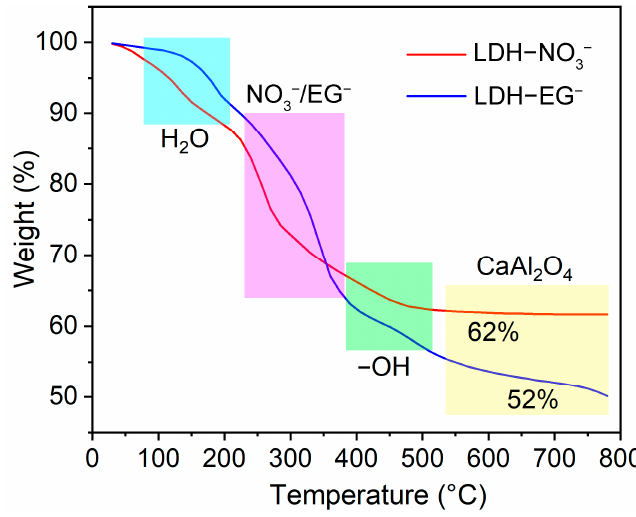
− and CaAl LDH–EG − . Figure 6. TG pro fi les for CaAl LDH − NO 3 − and CaAl LDH − EG − . Figure 6. TG profiles for CaAl LDH–NO 3 3.3. Corrosion Inhibition Performances of LDHs for Mild Steel in SCPs with 3.5% NaCl The corrosion inhibition performances of LDHs for mild steel in SCPs with